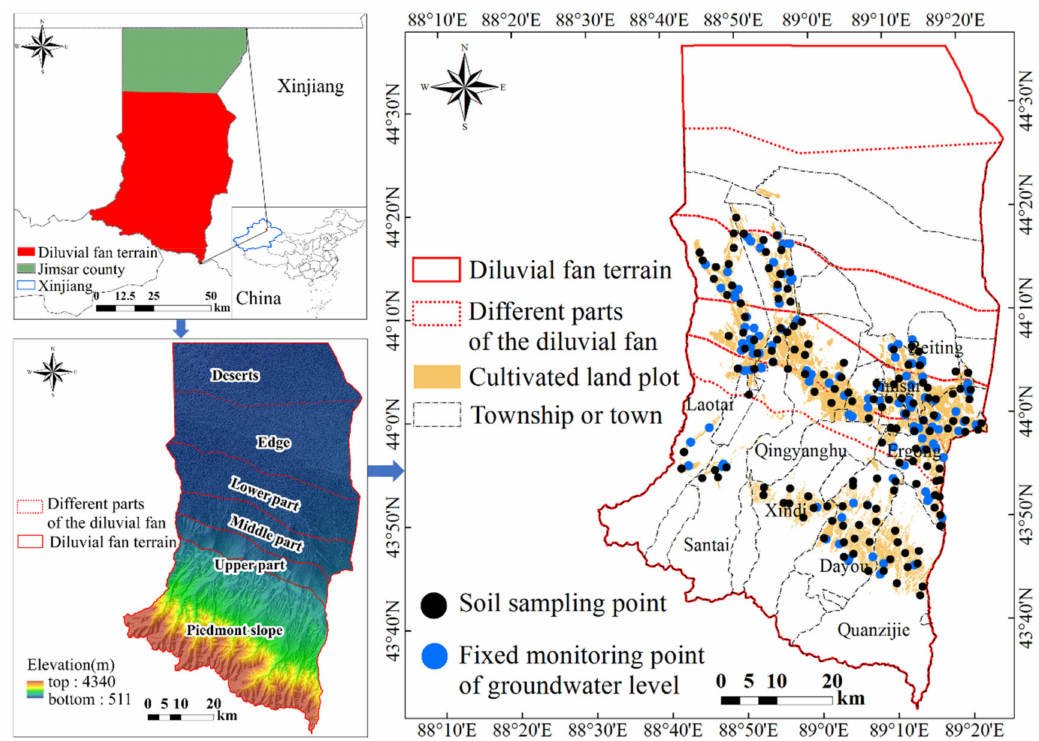
Figure 1. Location of the diluvial fan terrain and distribution of the sampling points in the research